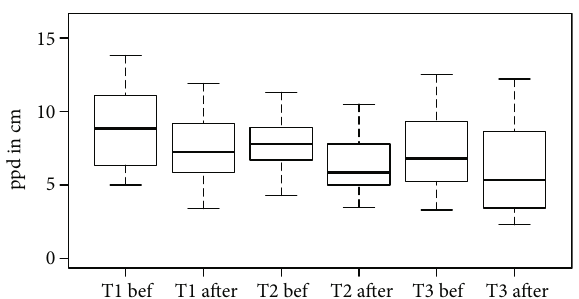
Figure 3: The proporioceptive drift (ppd) in cm for time points T1-T3 before and after the rubber hand illusion. The data is a mean of all participants.